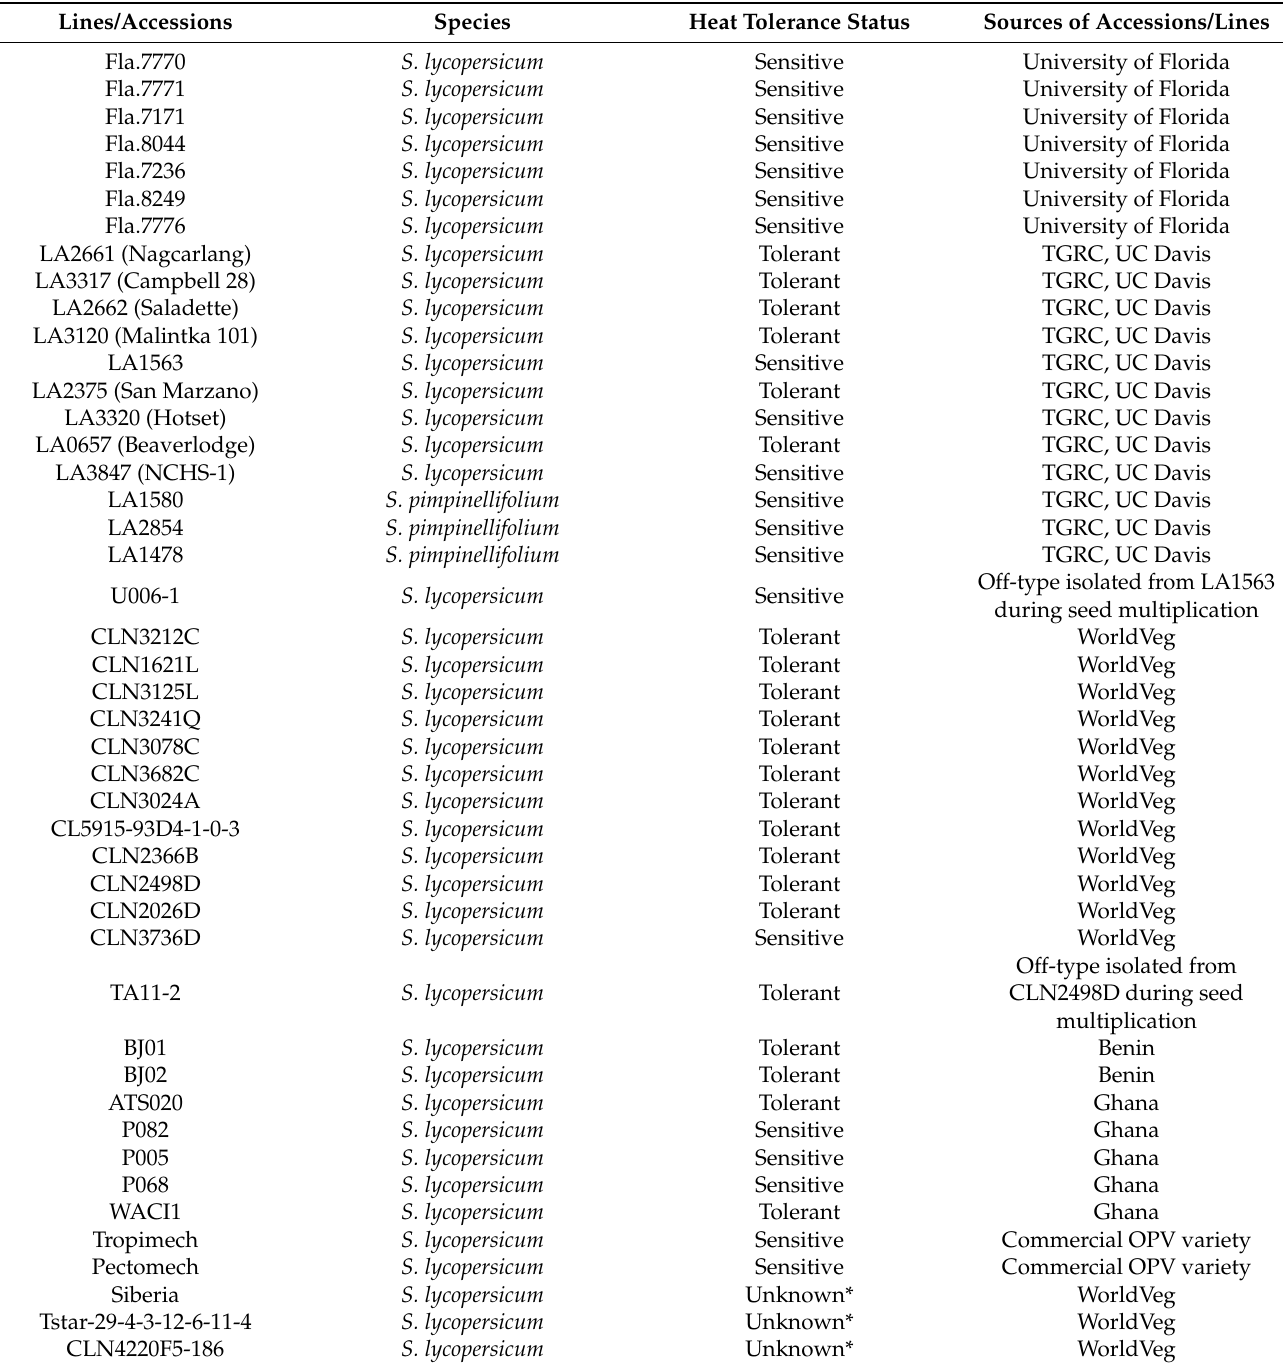
Table 1. Origins of accessions/lines